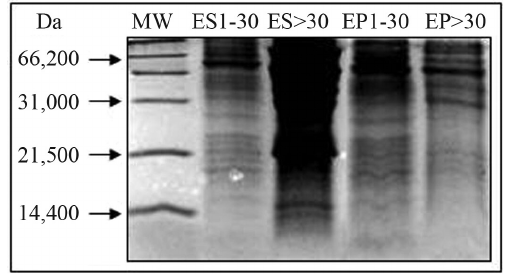
Figure 1 - Denaturing electrophoresis (16.5%) of soluble extracts (SE) and cell wall extracts (CWE) of leaves of soybean genotypes ‘PI 561356’ (Embrapa CNPSo) subjected to injury from seven wounds on the leaves. SE and CWE were fractionated by ultrafiltration and molecules contained between 1 and 10 kDa (1-10) and greater than 30 kDa (> 30). MM: 5 uL of the Wide-Range Molecular Weight Markers (Bio-Rad, USA). The peptide bandswerestainedwithCoomassieBrilliantBlueR250.(CourtesyofJosé Fabiano Sena-Netto, from the final paper for his undergraduate degree in Biochemistry in 2010 at the Federal University of Viçosa, Brazil).